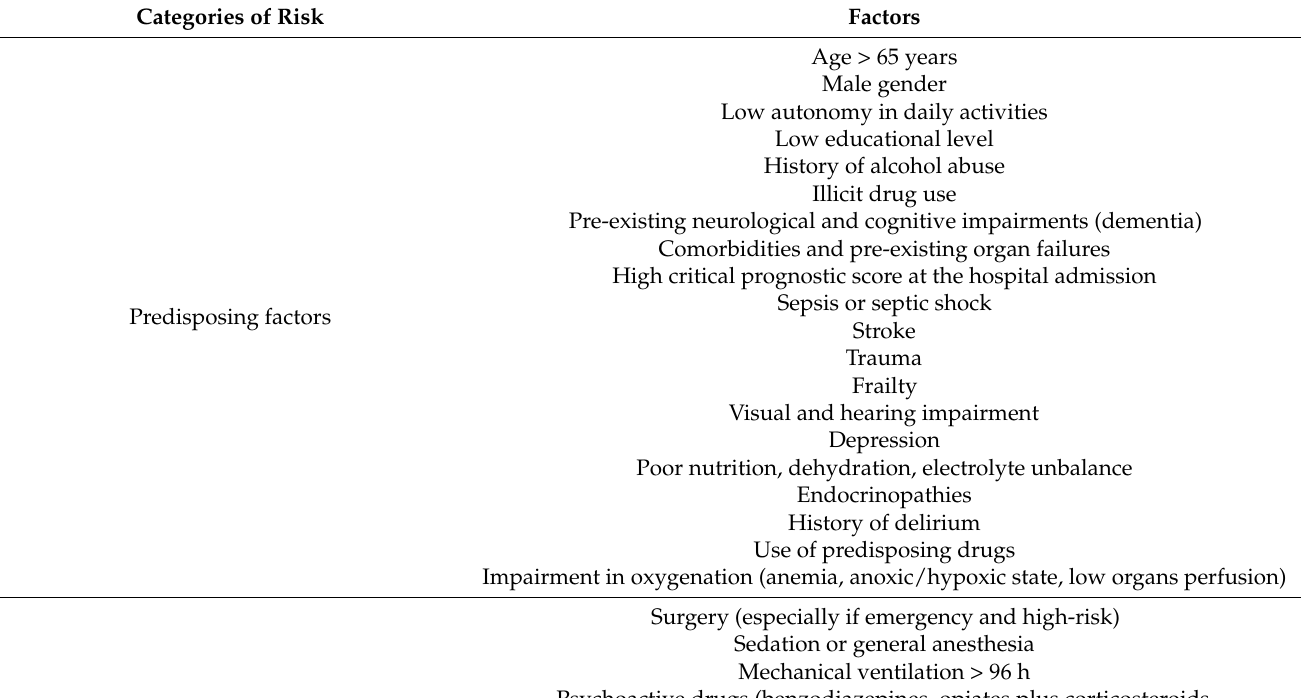
Table 1. Risk factors of developing postoperative